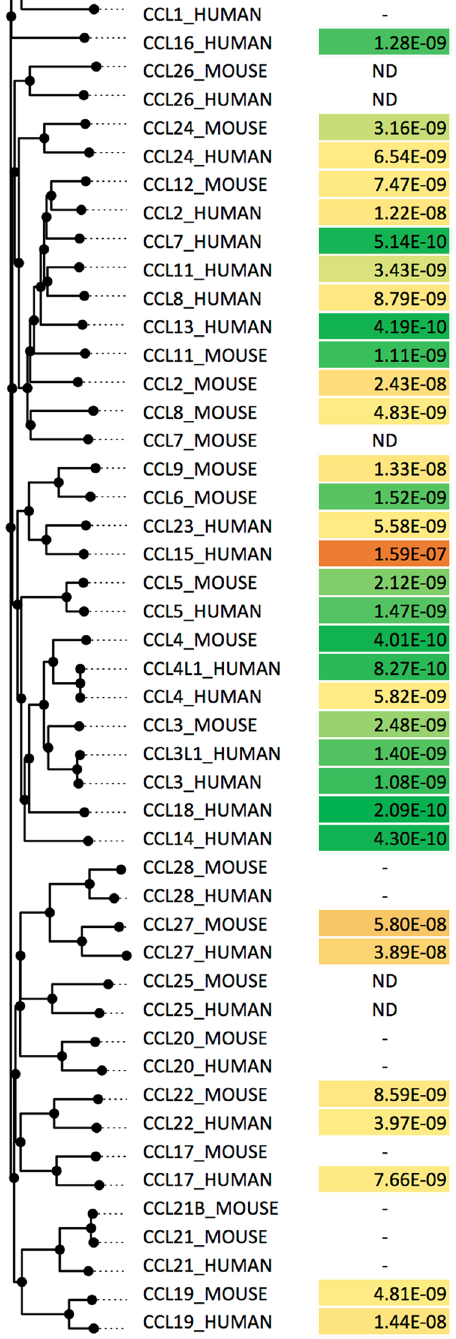
by yeast surface display, but may bind other chemokines or have functions other than chemokine binding.